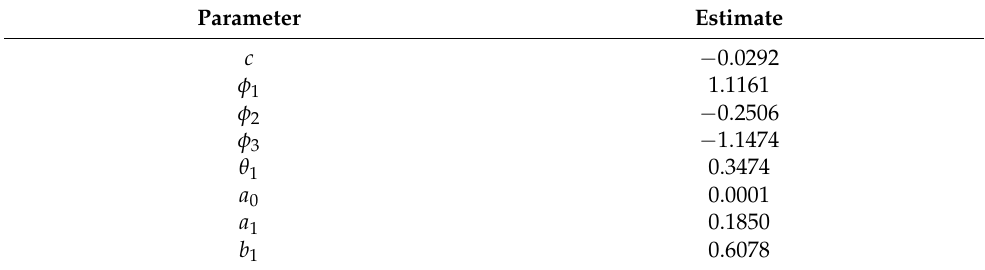
− GARCH ( 1,1 ) model. s = 96